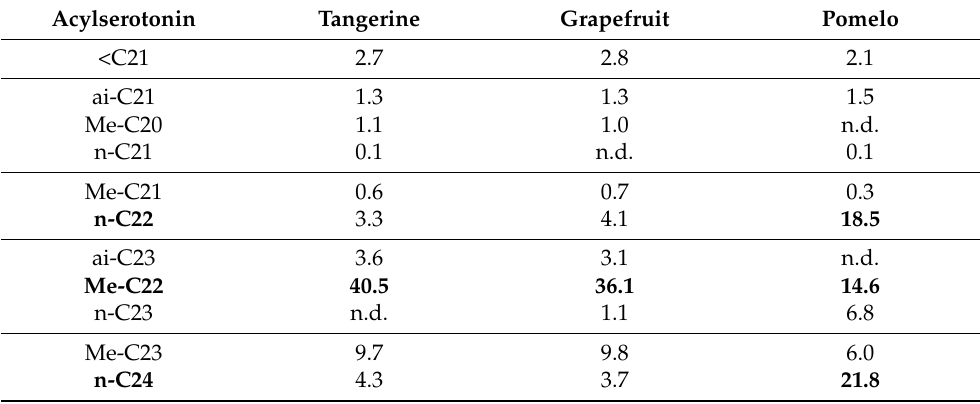
Table 3. Percent composition (mol%) of N -acylserotonins in seeds of various citrus species. Acylsero- tonins with the highest content are marked in bold. n.d.—not